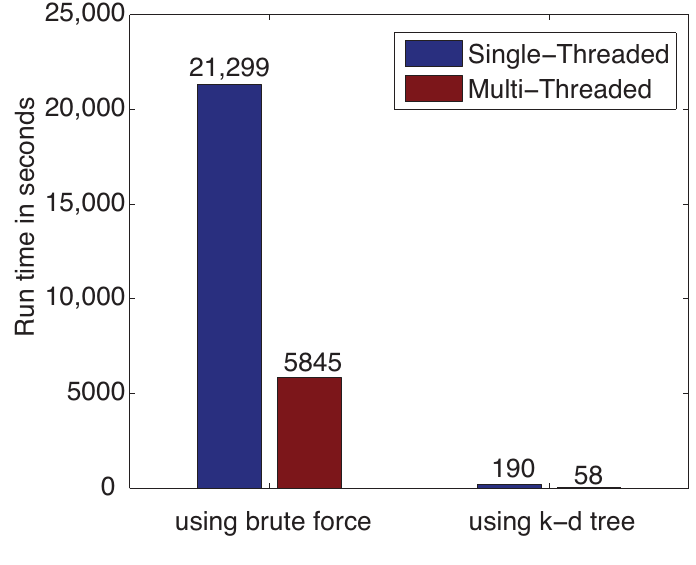
Figure 15. The effect of k-d tree with paralleling programming on IDW run time using the PM data at the county level. 2 : 5